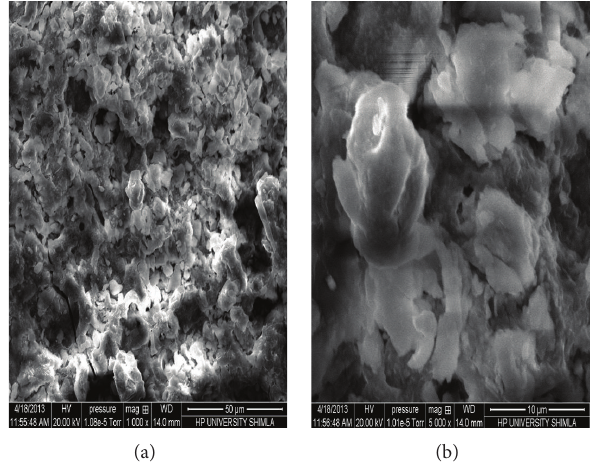
Figure 4: SEM images of ZnWO 4 .